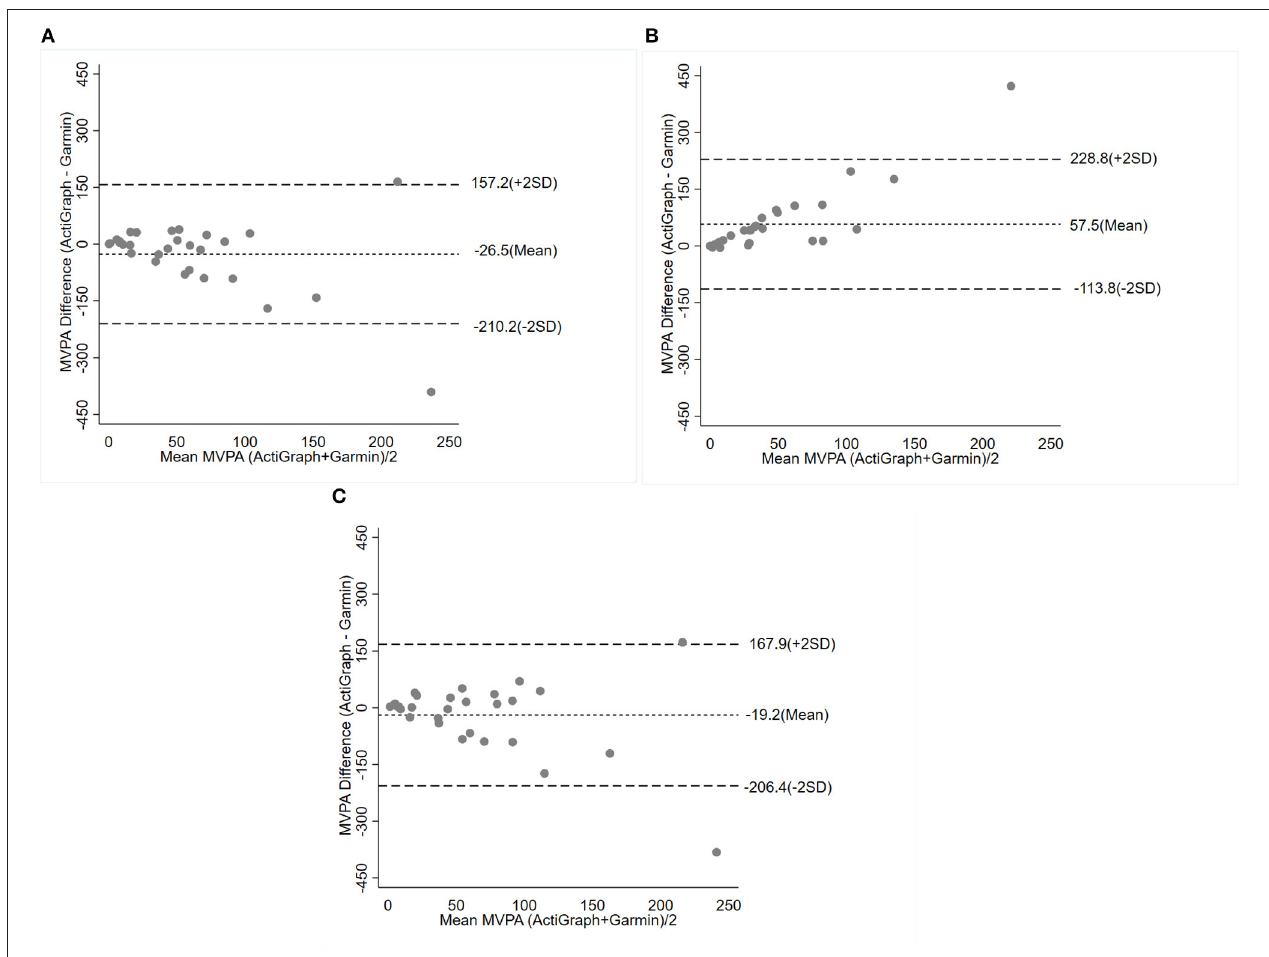
FIGURE 3 | Bland-Altman plot of the mean difference (bias) and 95% limits of agreement for minutes per day of moderate to vigorous physical activity (MVPA) determined by ActiGraph and compared with Garmin Vivosmart. The results are presented based on the threshold for MVPA: ≥ 1,013 counts/minute (A) , 0 ≥ 2,020 counts/minute (B) , ≥ 1,914 VM counts/minute (C) . Abbreviation : VM, vector